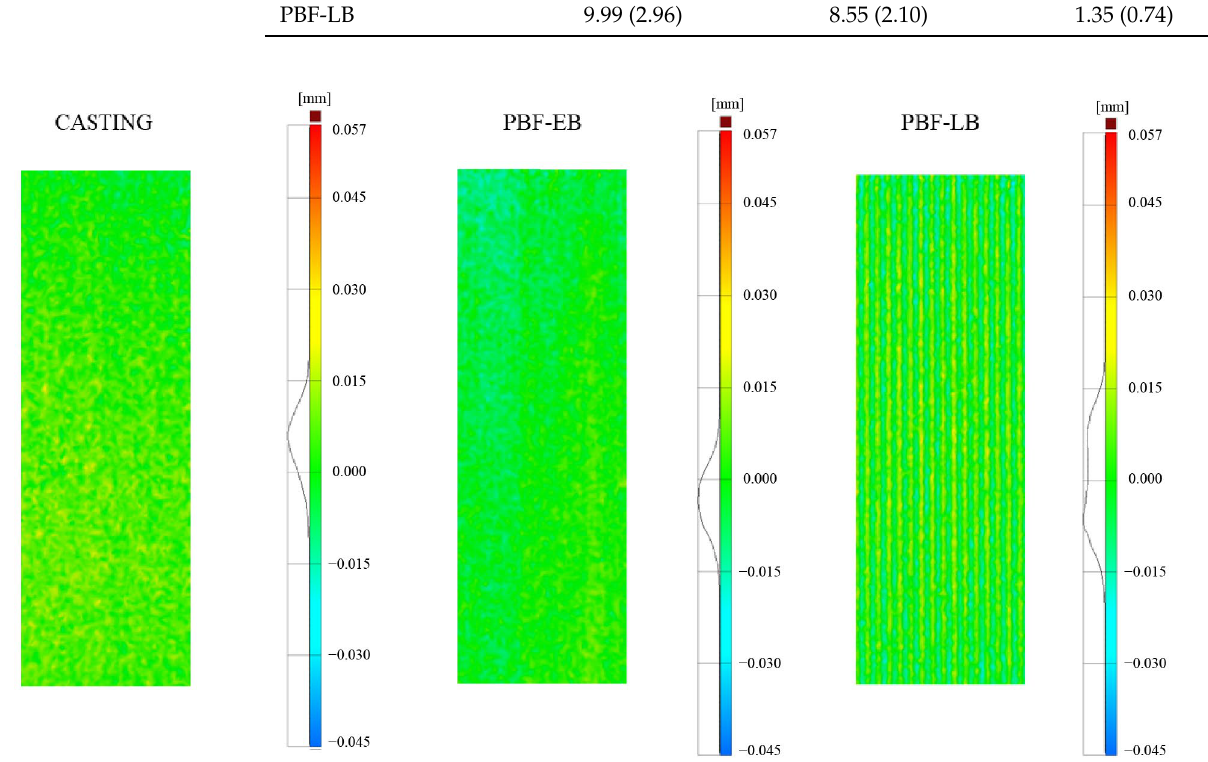
Figure 4. Surface topography images for samples produced with casting, PBF-EB, and PBF-LB, machined with the same process parameters (t on = 10 s, DC = 8.33%, I = 3 A, workpiece thickness = 20 mm).